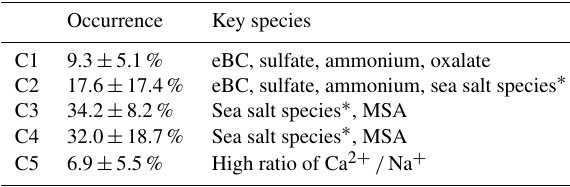
Table 1. Occurrence and key species for the five clusters. Occurrence Key